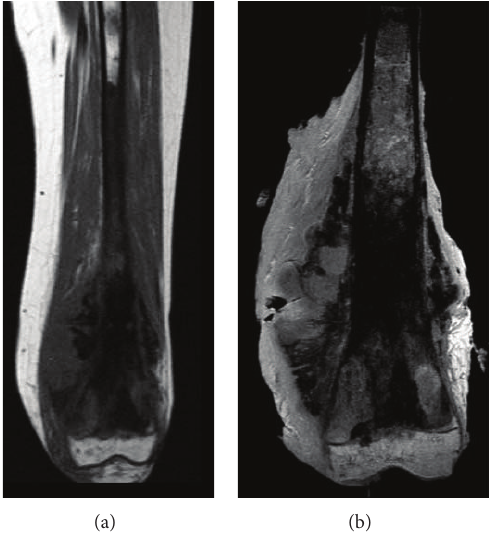
Figure 1: 11-year-old patient (n. 5) with osteosarcoma of the prox- imal tibia. A resection of the tumor was performed with epiphysis resection. The margin was classified R0 by pathologist, radiologist, and senior orthopaedic surgeon. On the left: preoperative MRI. On the right: postoperative MRI of the resected specimen.